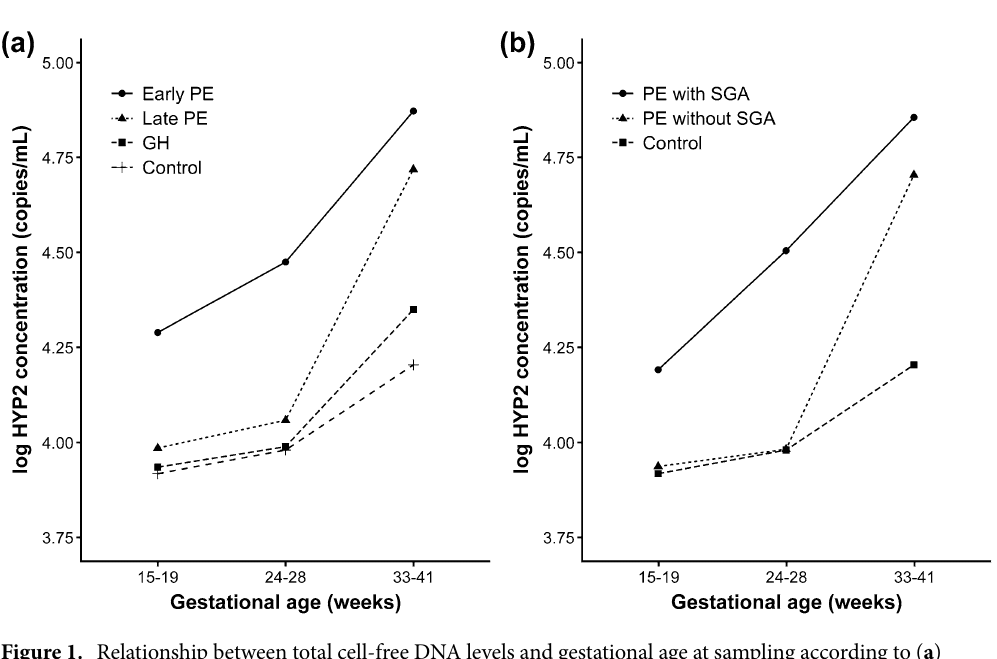
Figure 1. Relationship between total cell-free DNA levels and gestational age at sampling according to ( a ) onset-time of preeclampsia and ( b ) small-for-gestational-age neonate. GH gestational hypertension, PE preeclampsia, SGA small for gestational